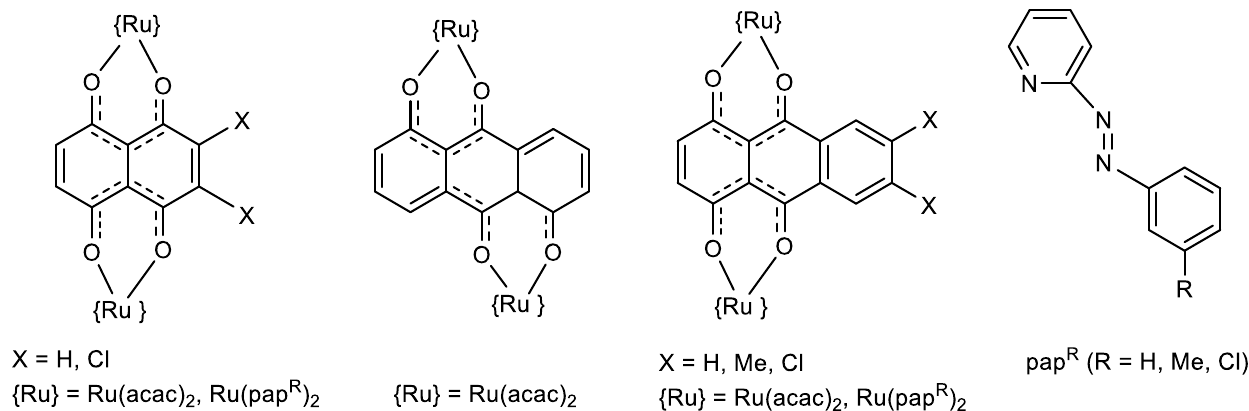
Figure 1. Examples of diruthenium complexes with bis(β-ketoenolate) bridging ligands capable of electronic coupling in the one-electron oxidized states.